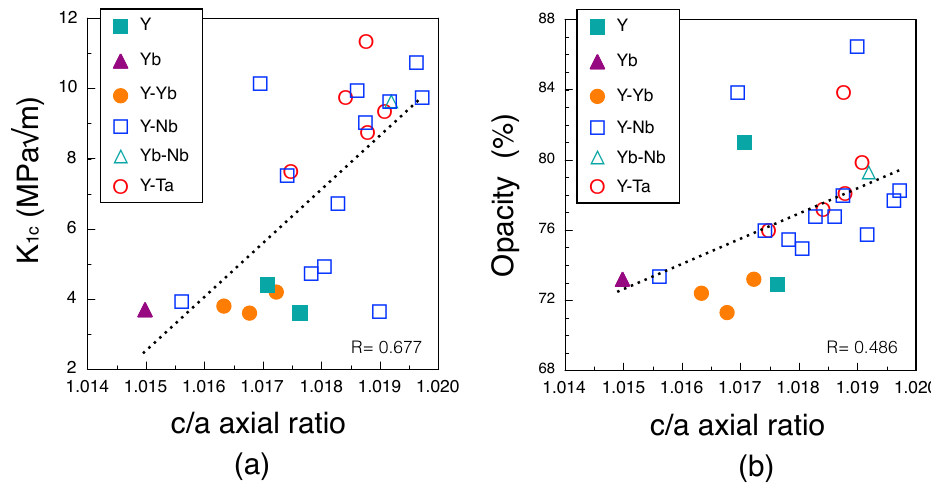
Figure 8. ( a ) fracture toughness value and ( b ) opacity of ZrO 2 -Y 2 O 3 (Y: No. 2 and 3), ZrO 2 -Yb 2 O 3 (Yb: No. 5), ZrO 2 -Y 2 O 3 -Yb 2 O 3 (Y-Yb: No. 6, 7 and 9), ZrO 2 -Y 2 O 3 -Nb 2 O 5 (Y-Nb: No. 10–20 and 22), ZrO 2 - Yb 2 O 3 -Nb 2 O 5 (Yb-Nb: No. 30), and ZrO 2— Y 2 O 3— Ta 2 O 5 (Y-Ta: No. 23–27) as a function of c/a axial ratio